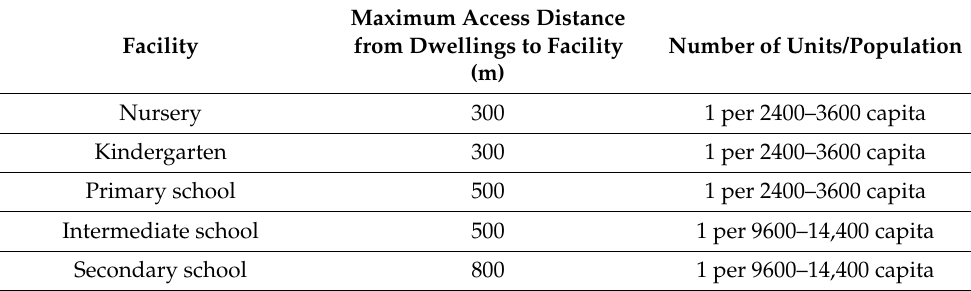
Table 4. Iraqi urban planning standards that refer to access distance to health care centres and schools, along with the size of social services required based on the number of